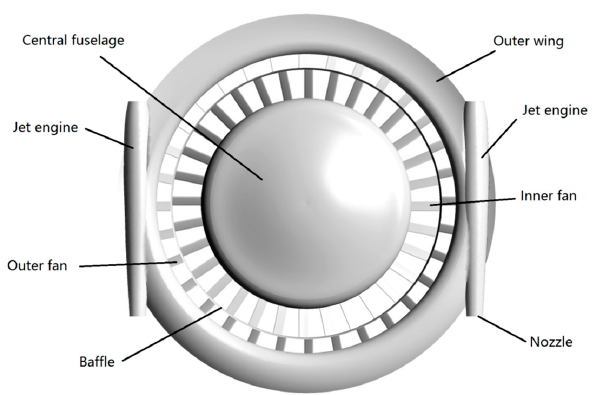
Figure 2. Annular lift fan aircraft [2–4]: Single-stage lift fan with an inner fan and an outer fan coupled by the gears in the baffle.